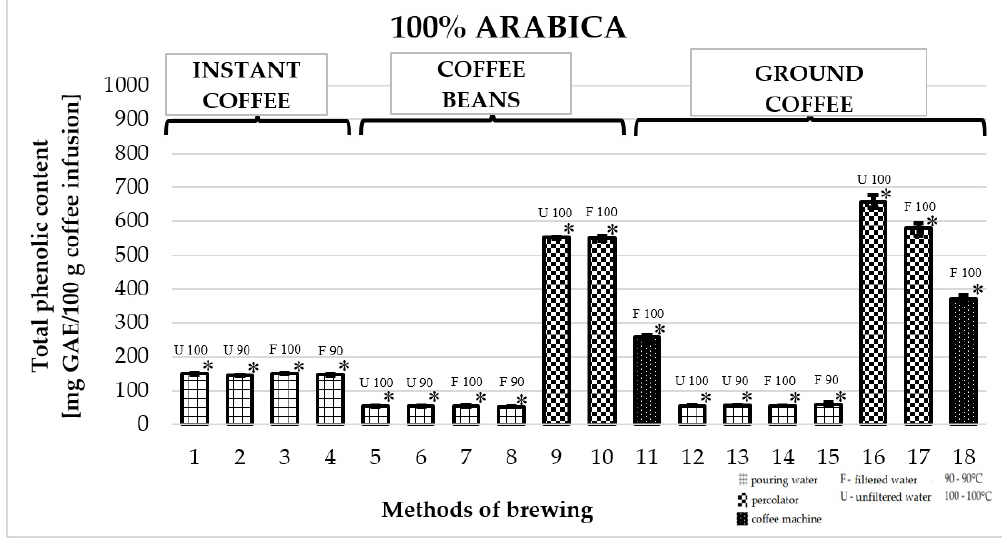
Figure 1. Median of total phenolic content as gallic acid equivalent [mg GAE / 100 g of infusion] in 100% Arabica coffee. * p 1/5,6,7,8,9,10,11,12,13,14,15,16,17,18 ; * p 2/5,6,7,8,9,10,11,12,13,14,15,16,17,18 ; * p 3/5,6,7,8,9,10,11,12,13,14,15,16,17,18 ; *